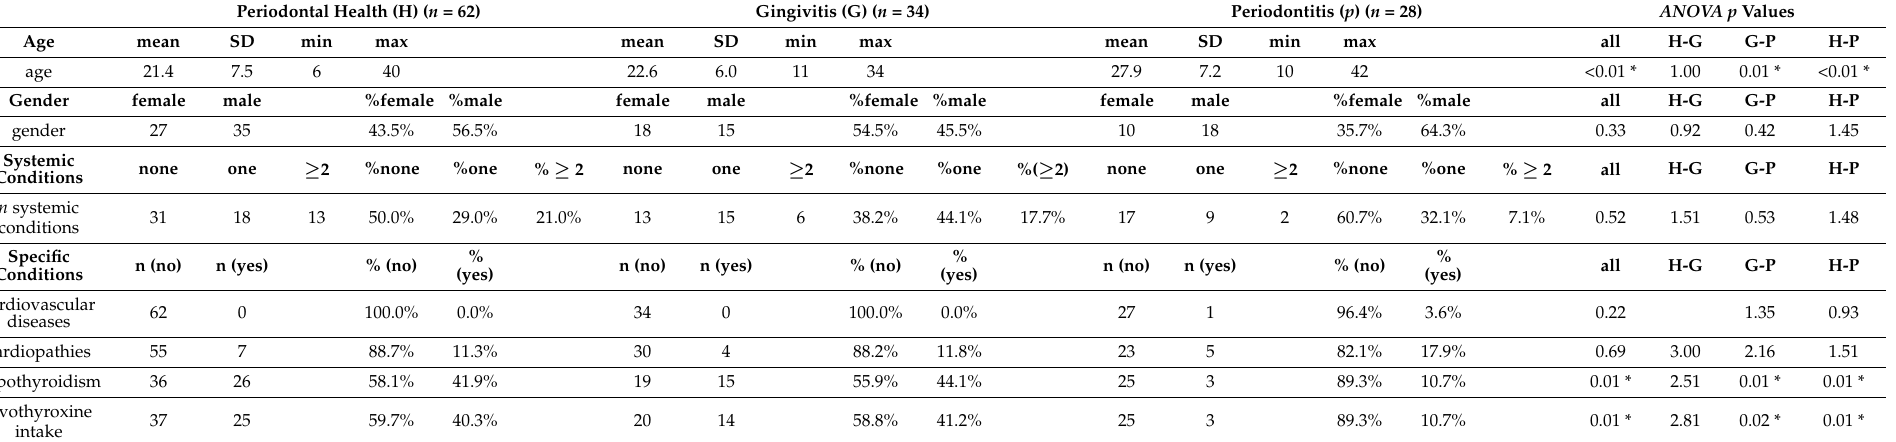
Table 1. Demographic characteristics for each study group, with the appropriate